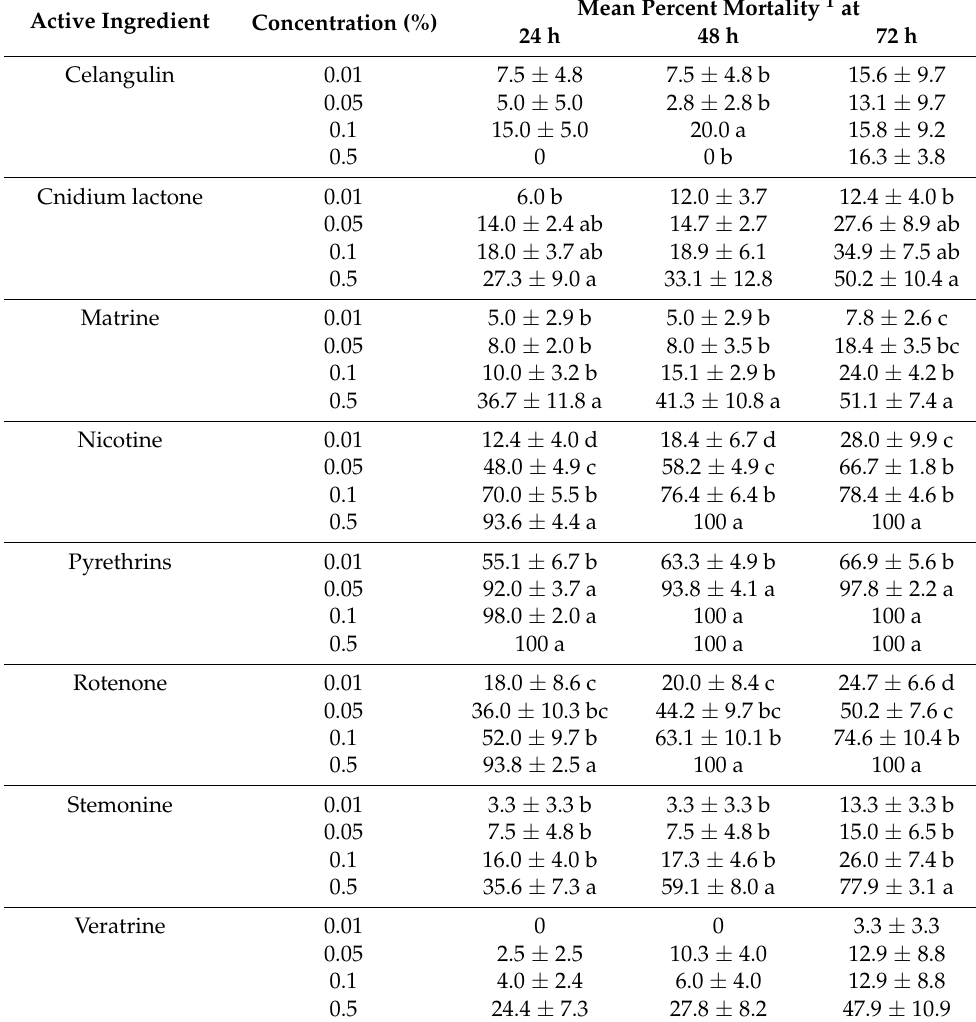
Table 4. Mean Abbott-corrected percent mortality ( ± SEM) of western flower thrips adults on periwinkle flowers dipped in plant extract and Tween 20 solutions in the fresh residue toxicity